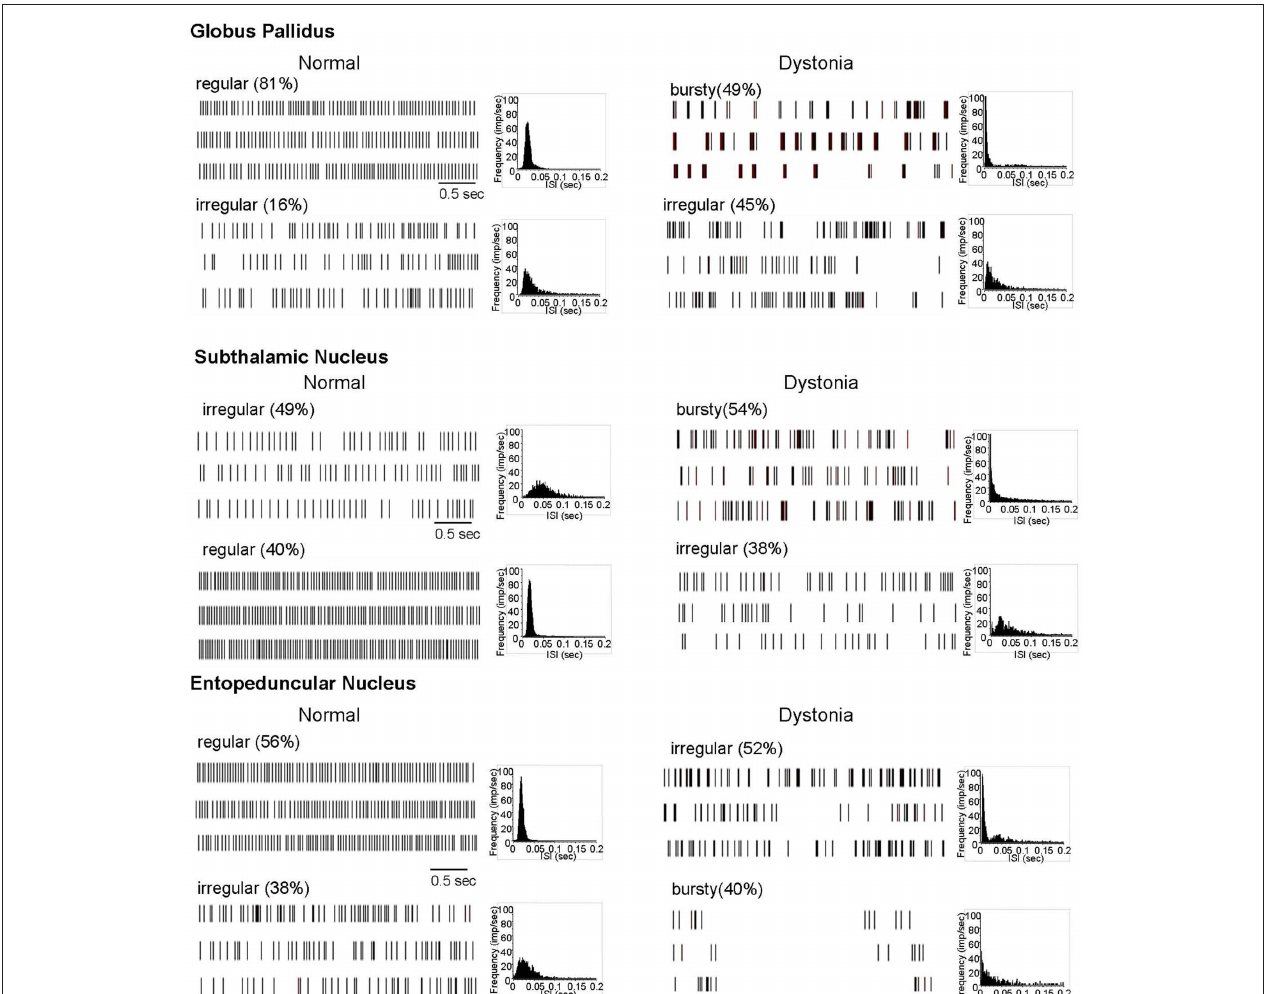
animals, most neurons discharged in either a bursty or highly irregular pattern. Three examples of spike rasters for each of the principal patterns are shown, along with grouped